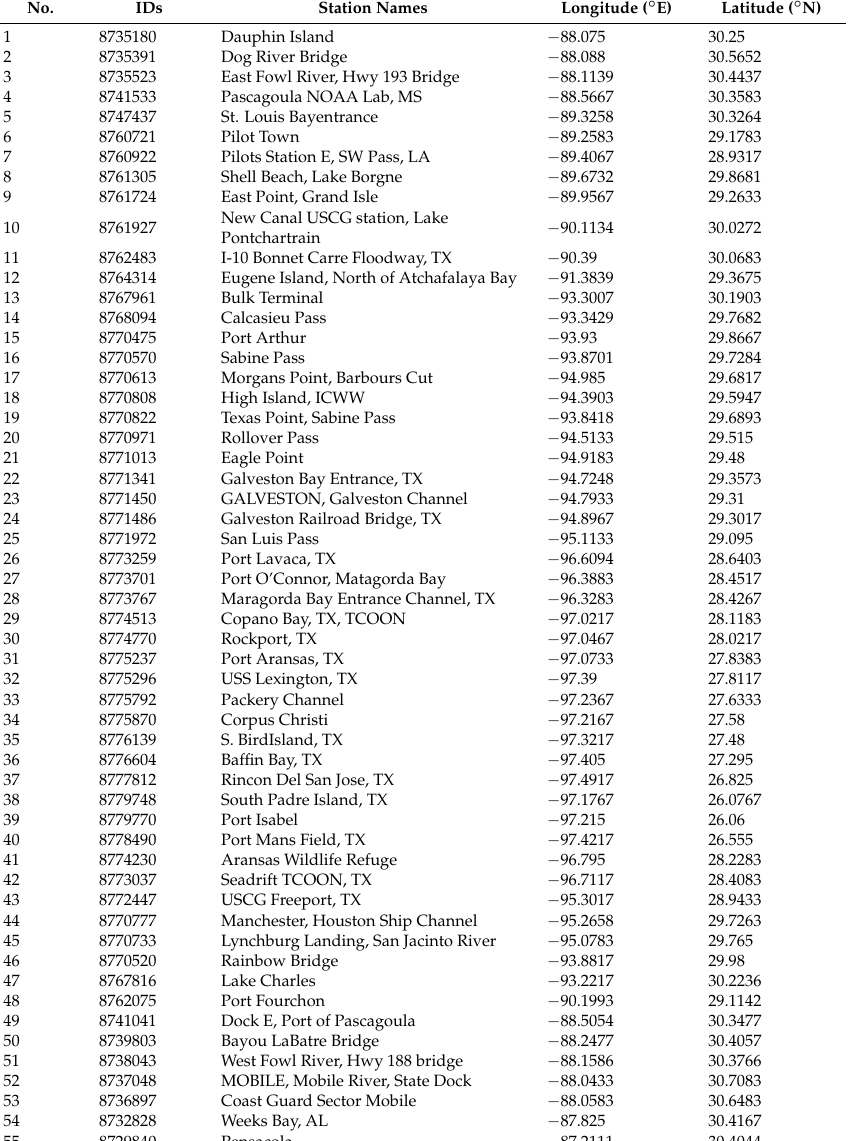
Table A1. Station meta data of water level